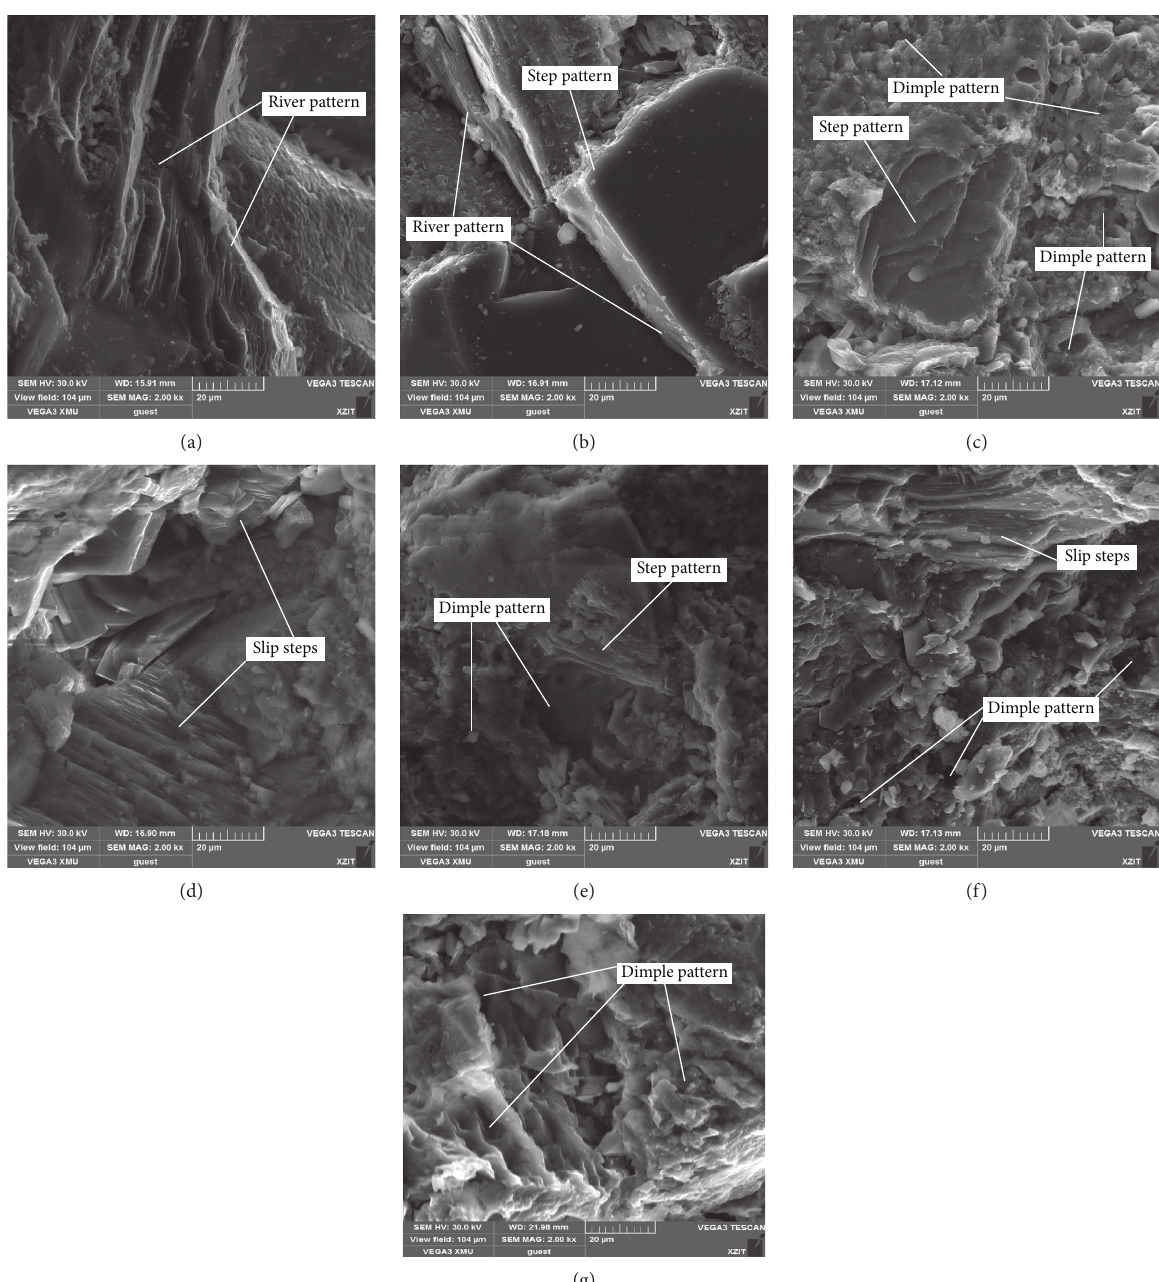
Figure 14: Sandstone fracture morphology with different moisture contents at 2000 times magnification: (a) ω � 0%, (b) ω � 2.01%, (c) ω � 2.23%, (d) ω � 2.40%, (e) ω � 2.49%, (f) ω � 2.53%, and (g) ω �